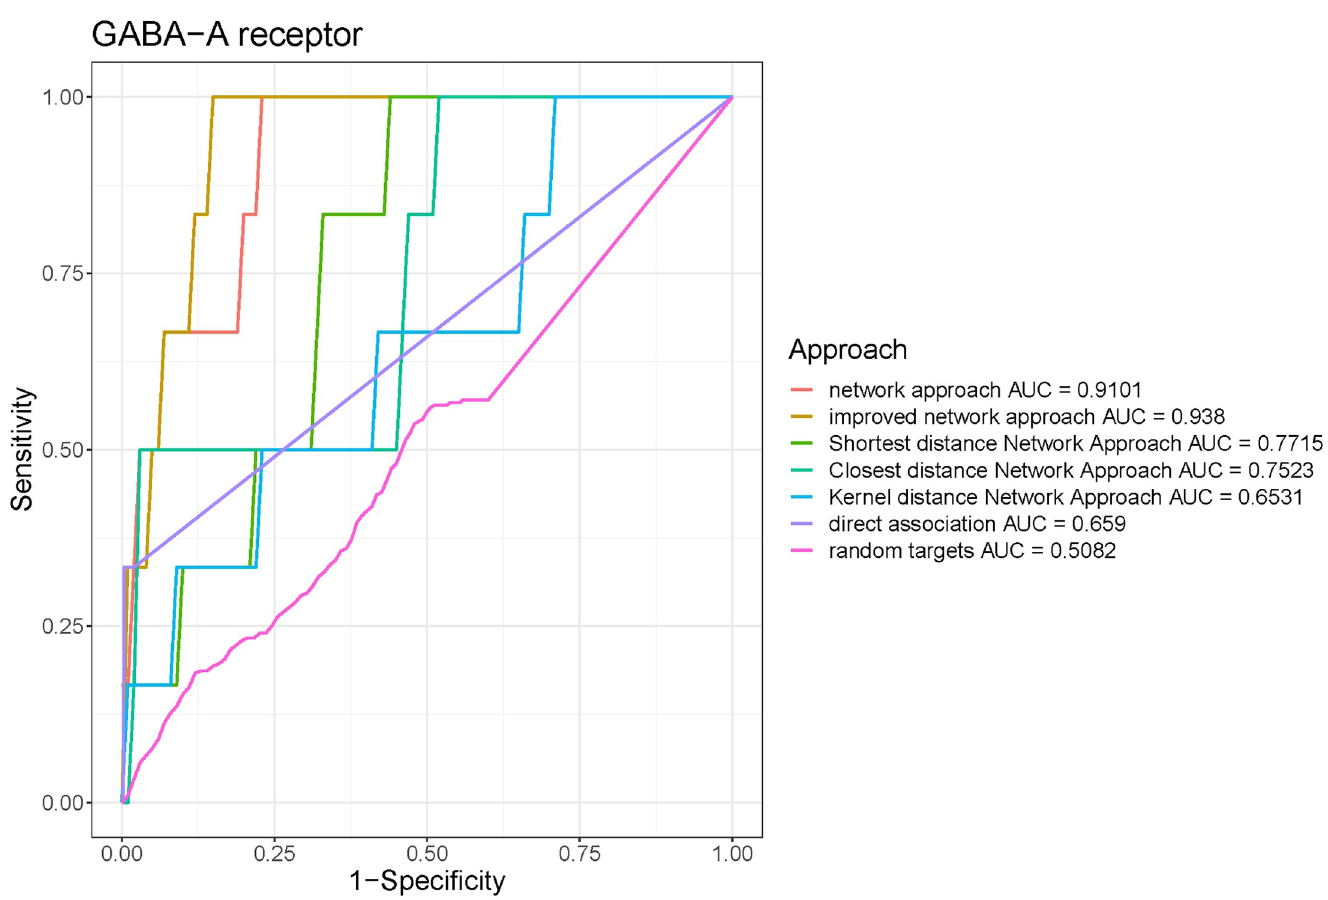
Fig 4. Receiver Operating Characteristic (ROC) curve showing the performance of different approaches on GABA-A receptor. The plot for network approach is characterized by an AUC (area under the curve) of 0.91.